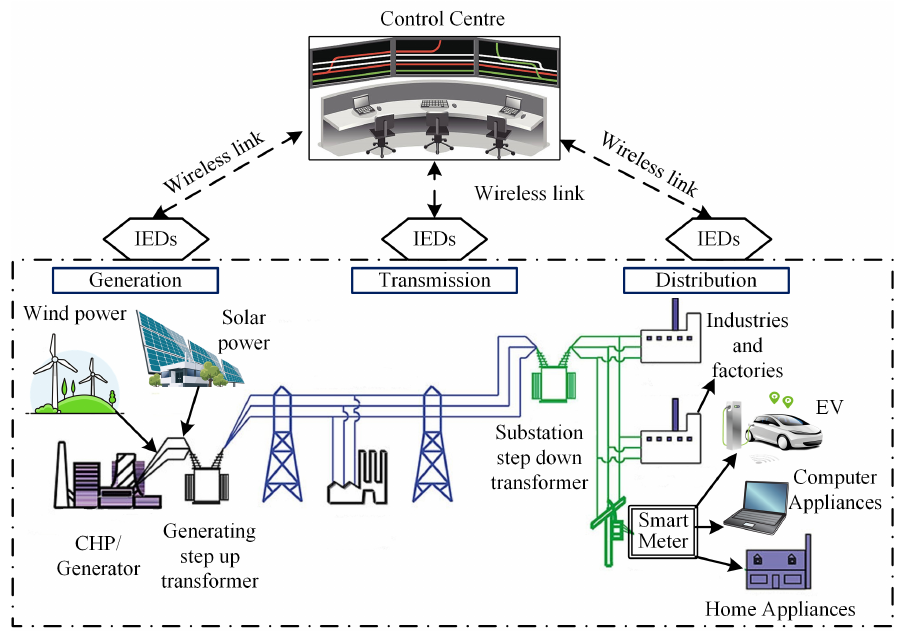
Figure 1. The intelligent electronic device (IED)-based smart cyber-physical power